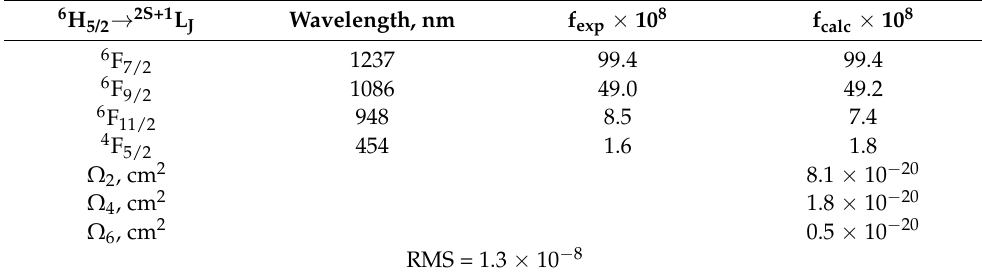
Figure 11. Energy diagram with possible transitions for [H 3 O][Eu(Q cy ) 4 ] 2 and [AgEu(Q cy ) 4 ] n 7 . Table 4. Experimental f exp and calculated f calc oscillator strengths, Judd–Ofelt parameters Ω t (t = 2,4,6), and root-mean-squared deviation RMS for complex H 3 O[Sm(Q cy ) 4 ] 1